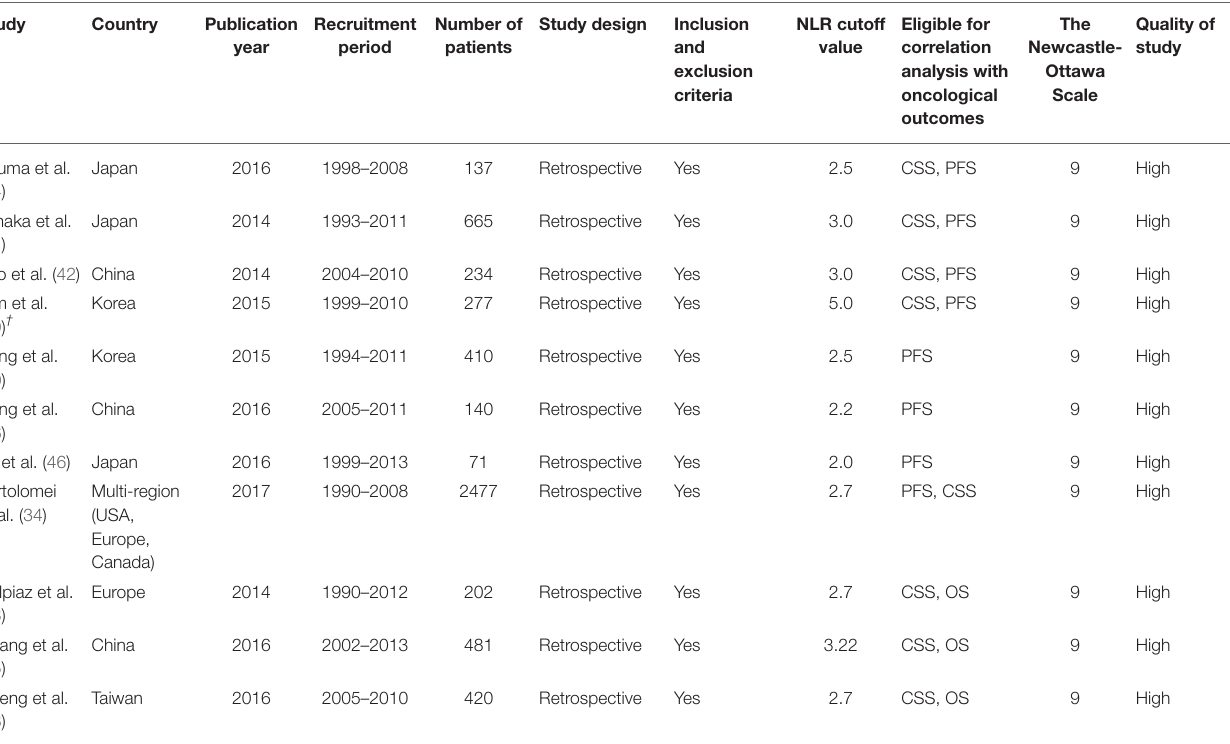
TABLE 4 | Characteristics of studies eligible for nephroureterectomy analysis.